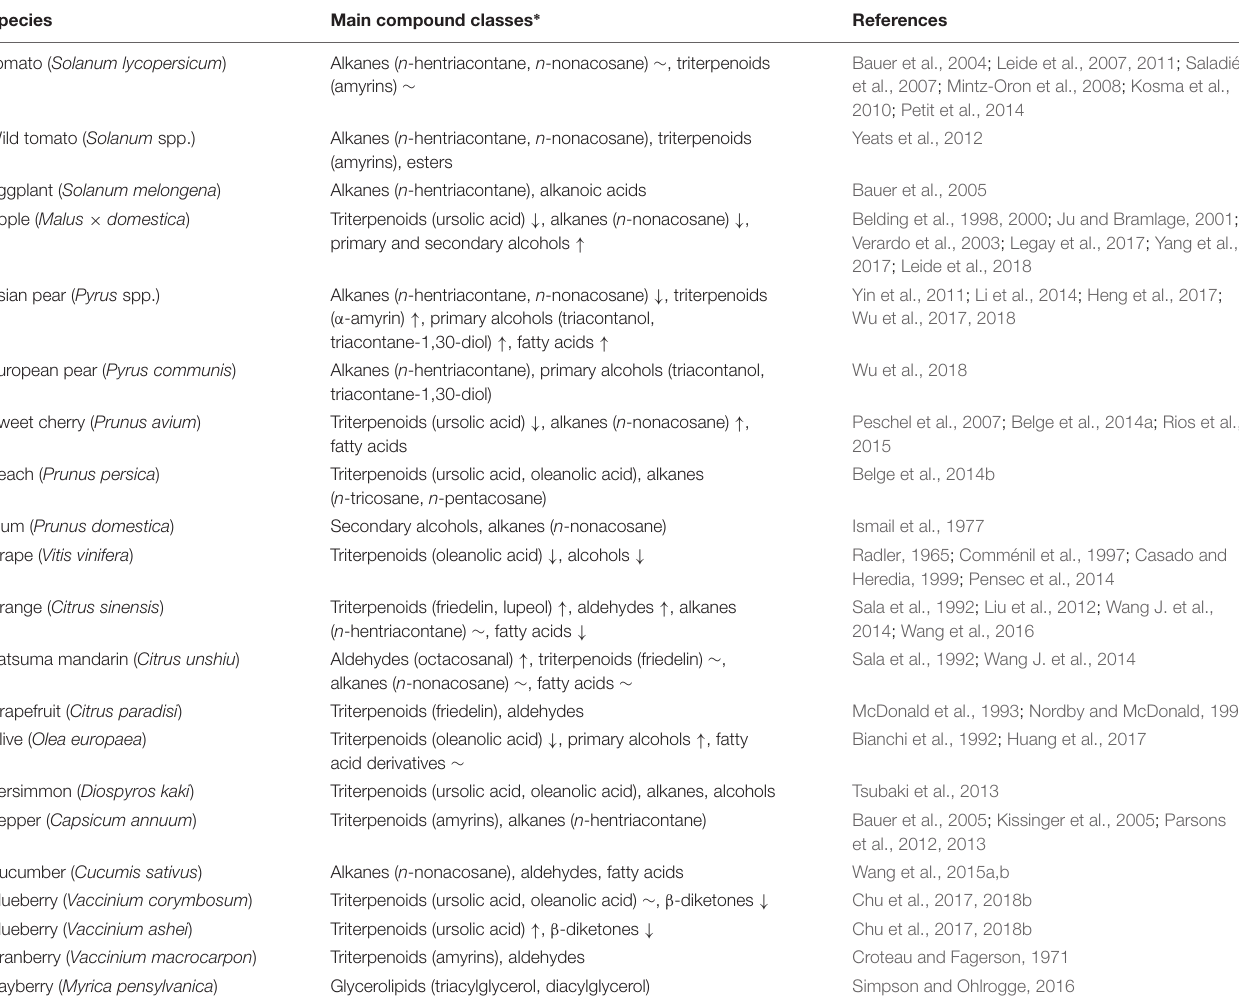
TABLE 1 | The main cuticular wax compound classes in various fleshy fruits at mature stage and changes during fruit development.